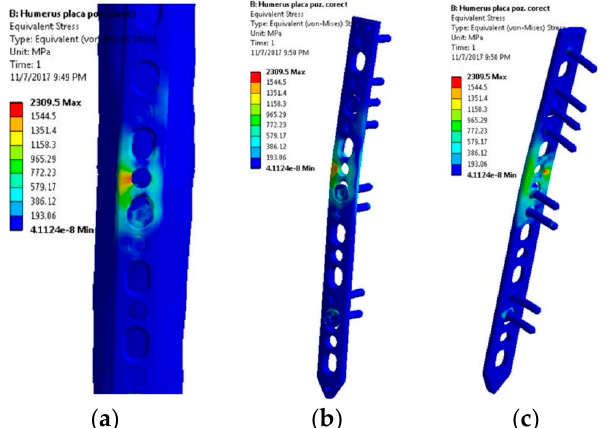
Figure 5. Stress distribution within the LCP when a 10 kg mass is lifted—flexion movement tendency: